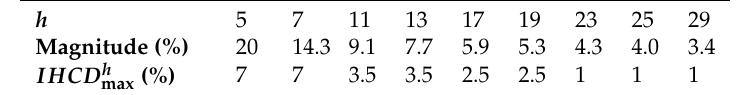
Table A1. The harmonic current spectrum of a typical nonlinear load, and the corresponding limits [34]. h